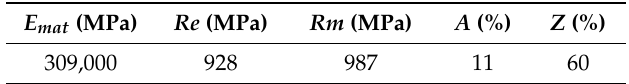
Table 3. Mechanical parameters for 15230QT, where Z is a contraction.